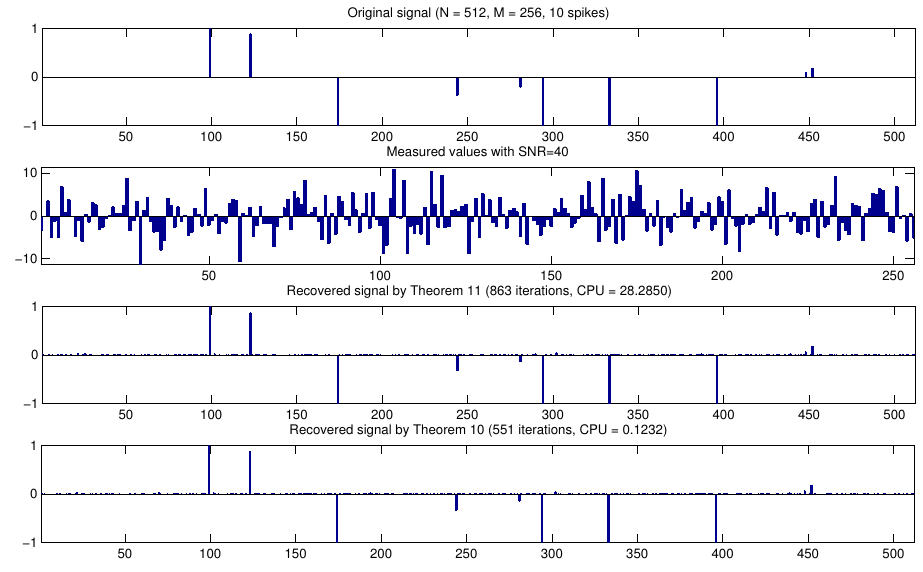
Figure 3. From top to bottom: original signal, measured values, recovered signal by Theorem 11 and Theorem 10 with N = 512, M = 256 and m =